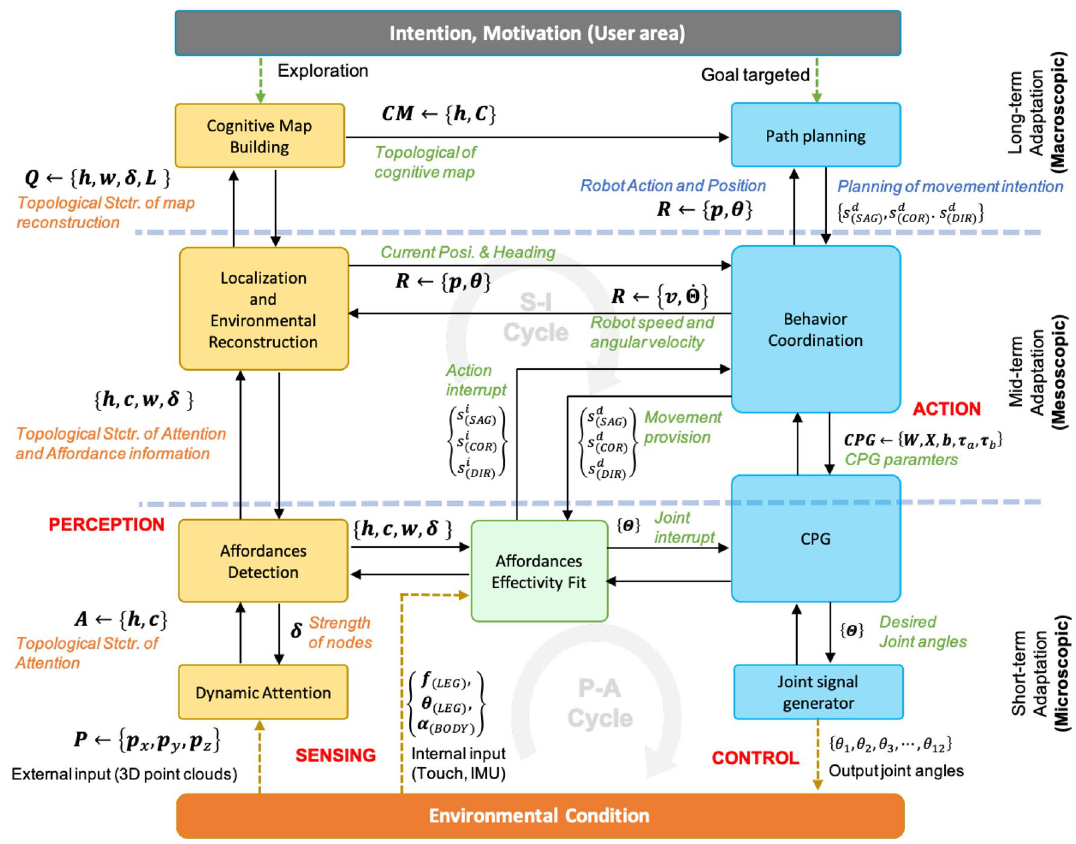
Figure 5. Overall design of multiscopic neuro-cognitive model. The system is integrated from micro-, meso-, ˜ 20ms and macro-scopic level. The data transfer in Microscopic level updated every time cycle ( ), Mesoscopic ˜ 500 ms level updated every time step ( ), Macroscopic level updated if there is different intention. We use 3D point cloud only as external input notated by P , composed as p x , p y , p z , and use leg force f ( LEG ) , joint position θ ( LEG ) , and body tilt θ ( LEG ) , as the internal input. P is processed in Dynamic Attention ( DA ) module then generates topological based attention notated as A composed as 3D nodes position h N and edges c N , A × 3 A × N A where N A is the number of nodes. Those information are transferred to Affordance Detection ( AD ) module and send strength node feedback δ to the DA module. AD generate topological structure A with vector of curvature in each node w and strength of node δ to Affordance Effectivity fit (AIf) module and Localization and Environmental Reconstruction (LER) module. AIf module received internal input and information from AD and behavior coordination (BC) module to generate action interrupt ( s i SAG , s i COR , s i DIR ) to BC and joint interrupt (� ( i ) ) to CPG module. LER module generate topological based map reconstruction notated by Q , composed as node position ( h ), vector direction ( h ), strength of node ( δ ), and node label ( L ) to cognitive map building (CMB) module. LER also send robot position ( R ) to behavior coordination (BC) module, where h composed as 3D position ( h ) and 3D vectorheading ( θ ). CMB module generates cognitive map information ( CM ), composed as a cognitive map node ( h ) and costs ( C ) to the path planning (PP) module. Based on the goal position, PP module generate movement provision in sagital, coronal, turning movement ( s d SAG , s d COR , s d DIR ) to BC. BC module send CPG based action parameter ( CPG , composed as CPG synaptic weights ( W , X ), degree of adaptation ( b ), time constants τ a and τ b . CPG generates output in joint angle level ( (cid:31)